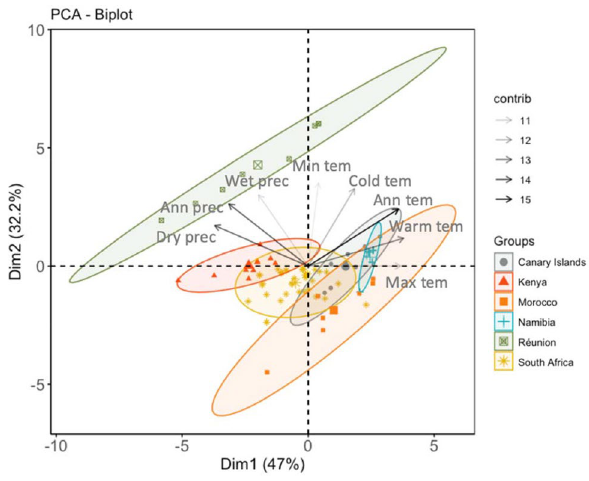
Figure 3. Principal Component Analysis (PCA) ordination of explored regions based on the two principal climatic gradients. The enlarged symbols indicate the centroids of the inertia ellipses while arrows indicate the importance of each bioclimatic variable on the two significant components. Climatic predictors are: Ann tem annual mean temperature, Max tem maximum temperature of the warmest month, Min tem minimum temperature of the coldest month, Warm tem mean temperature of the warmest quarter, Cold tem mean temperature of the coldest quarter, Ann prec annual precipitation, Wet prec precipitation of the wettest quarter, Dry prec precipitation of the driest quarter. The figure was created using JMP Pro ver13 (SAS, Cary, NC).